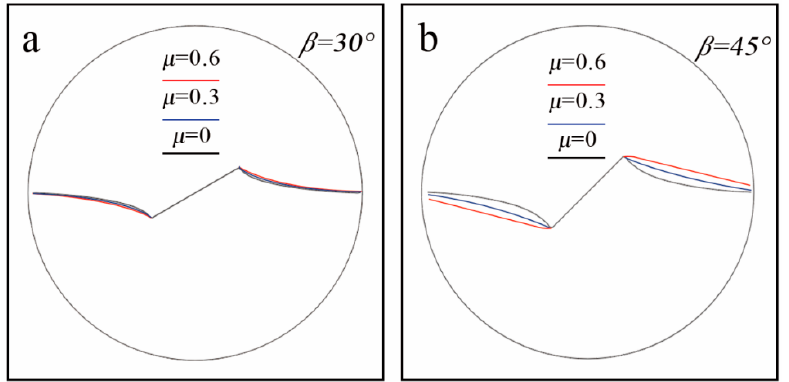
Figure 9. The propagation trajectories simulated by the MFEM under different friction coefficients for α = 0.3.